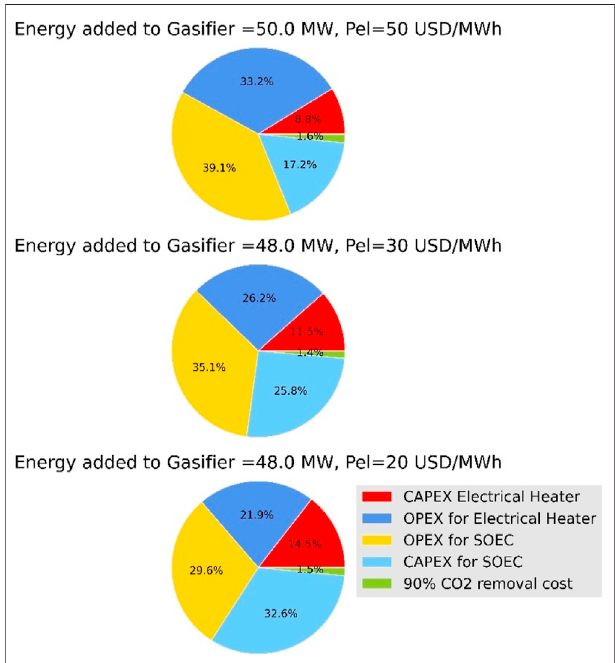
FIGURE 12 | Distribution of costs for the SOEC scenario with cheaper electricity